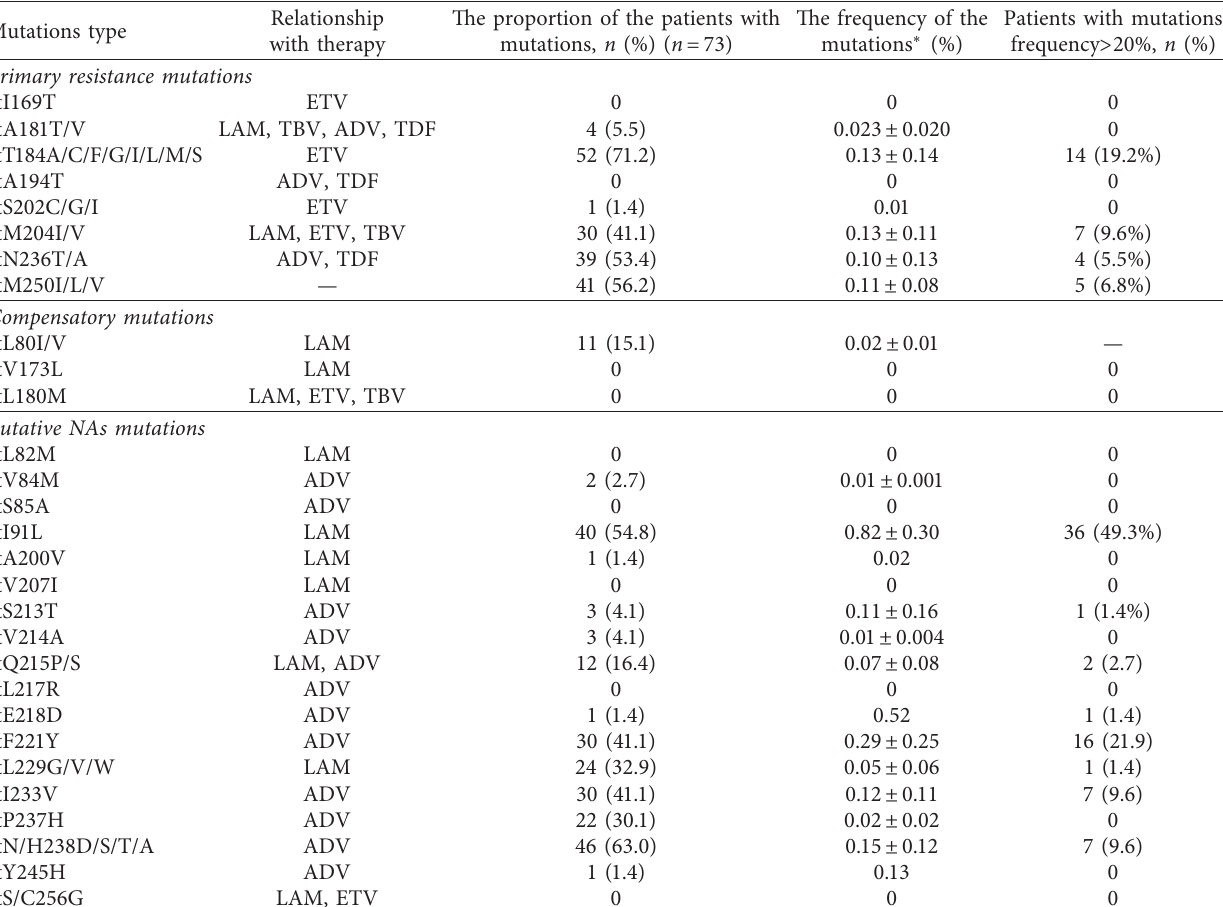
Table 2: Potential NAs mutation at 29 positions of HBV reverse transcriptase analyzed in the 73 pregnant